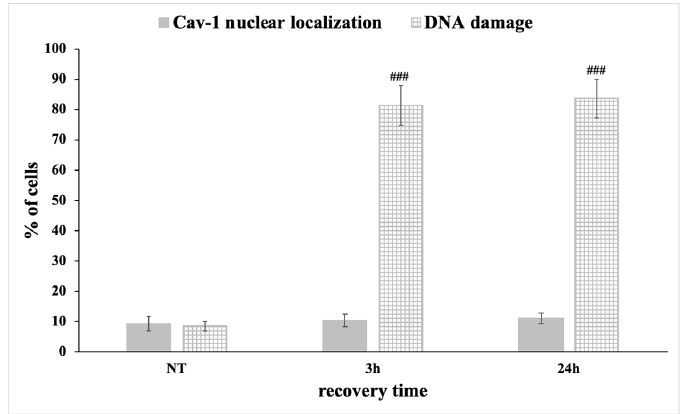
Figure 11. Prevention of caveolin-1 nuclear translocation inhibits DNA lesions restoration. Percentages of three different control chondrocytes pre-treated with filipin for 24 h with nuclear localization of caveolin-1 and DNA damage lesions (>5 foci stained with γΗ 2 ΑΧ ) under normal conditions (No Treatment—NT) and at different time points of recovery from the oxidative treatment (3 h, 24 h). Values shown are the means ± S.E. ### p < 0.001versus NT. p values were calculated using the Student t -test .